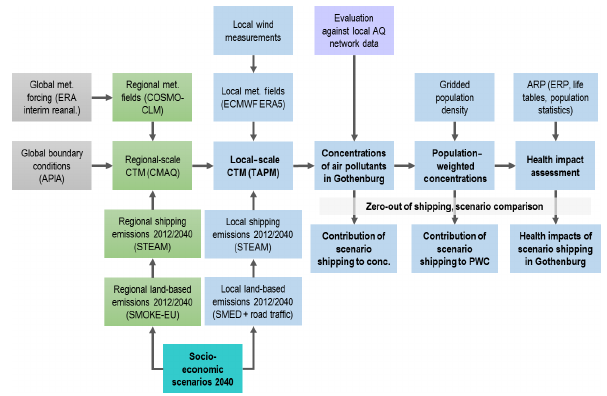
Figure 2. Study design to calculate future concentrations, popula- tion exposure, and health